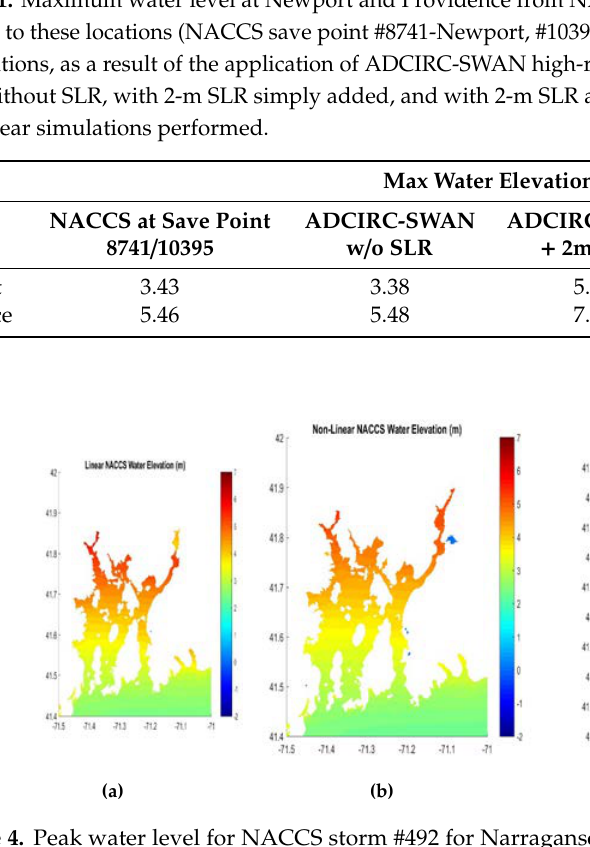
Figure 4. Peak water level for NACCS storm #492 for Narragansett Bay for ( a ) linear superposition method, ( b ) full nonlinear simulation results, and ( c ) percent (%) difference between the two for 6.6-ft (2-m) SLR.